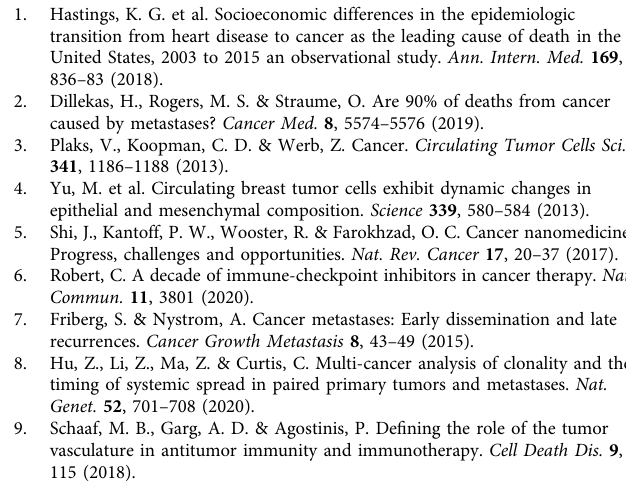
Fig. 6 CAM tumors possess typical characteristics of human breast cancers. a MDA CAM tumor: H&E staining revealing a distinct small CAM tumor with clearly visible blood vessels and ill-de fi ned borders, morphologically reminiscent of a small breast cancer lesion. Cancer cells within the CAM tumors were positive for CK18 and human mitochondria (Hu-Mito) and negative for human ER α . Anti-human CD34 staining revealed blood vessels lined by